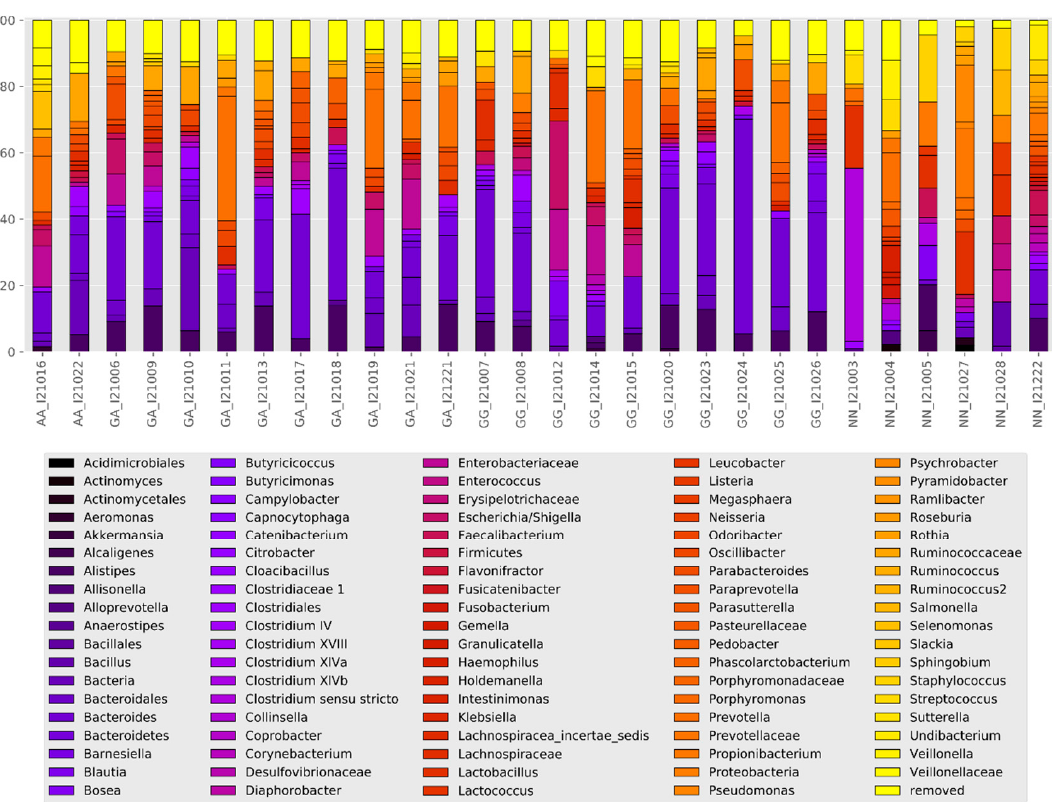
Figure 4. Stool microbiota composition.